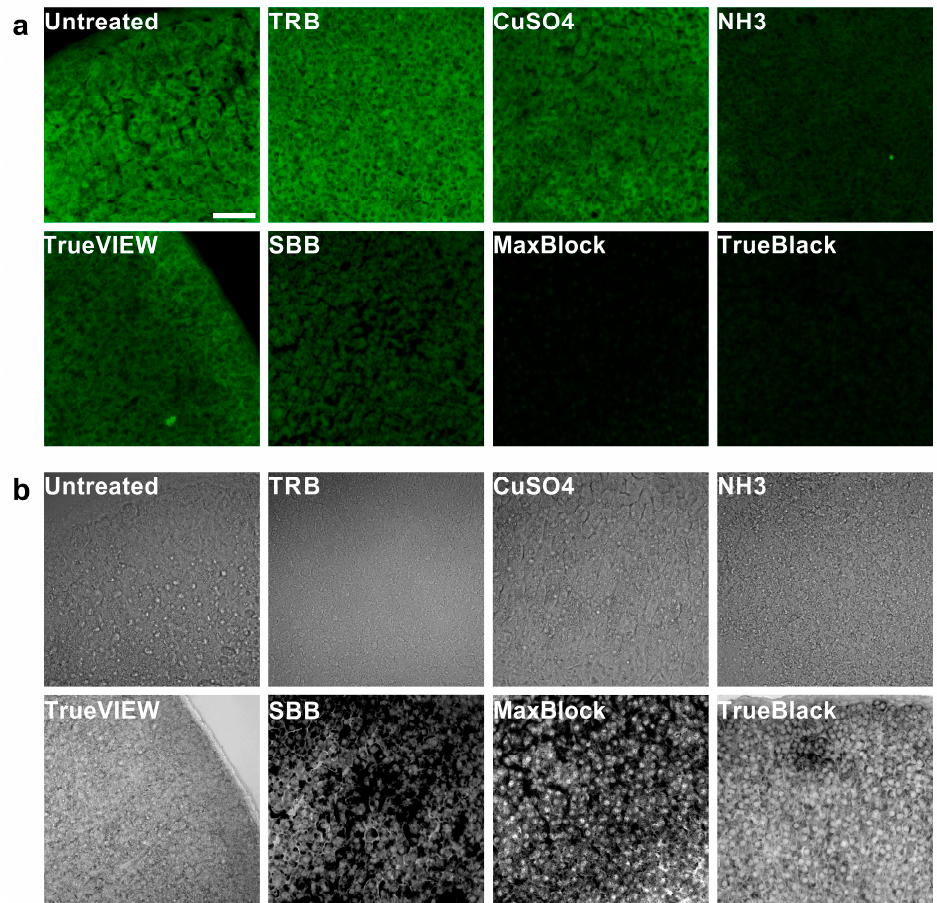
Figure 2. Reducing green wavelength autofluorescence in PFA-fixed mouse adrenal cortex tissue sections using various AF reduction methods. The effect of different tissue treatments on the adrenal cortex green wavelength autofluorescence ( a ), and tissue staining and integrity ( b ). Images were acquired with Olympus FluoView™ FV3000 using 488 nm excitation and a 500–600 nm detection range. Transmitted images were taken simultaneously at 488 nm excitation. Bar: 50 μ m. Abbrevia- tions: TRB, trypan blue; TrueVIEW, TrueVIEW TM Autofluorescence Quenching Kit; SBB, Sudan Black B; TrueBlack, TrueBlack TM Lipofuscin Autofluorescence Quencher; MaxBlock, MaxBlock TM Autofluorescence Reducing Reagent Kit.